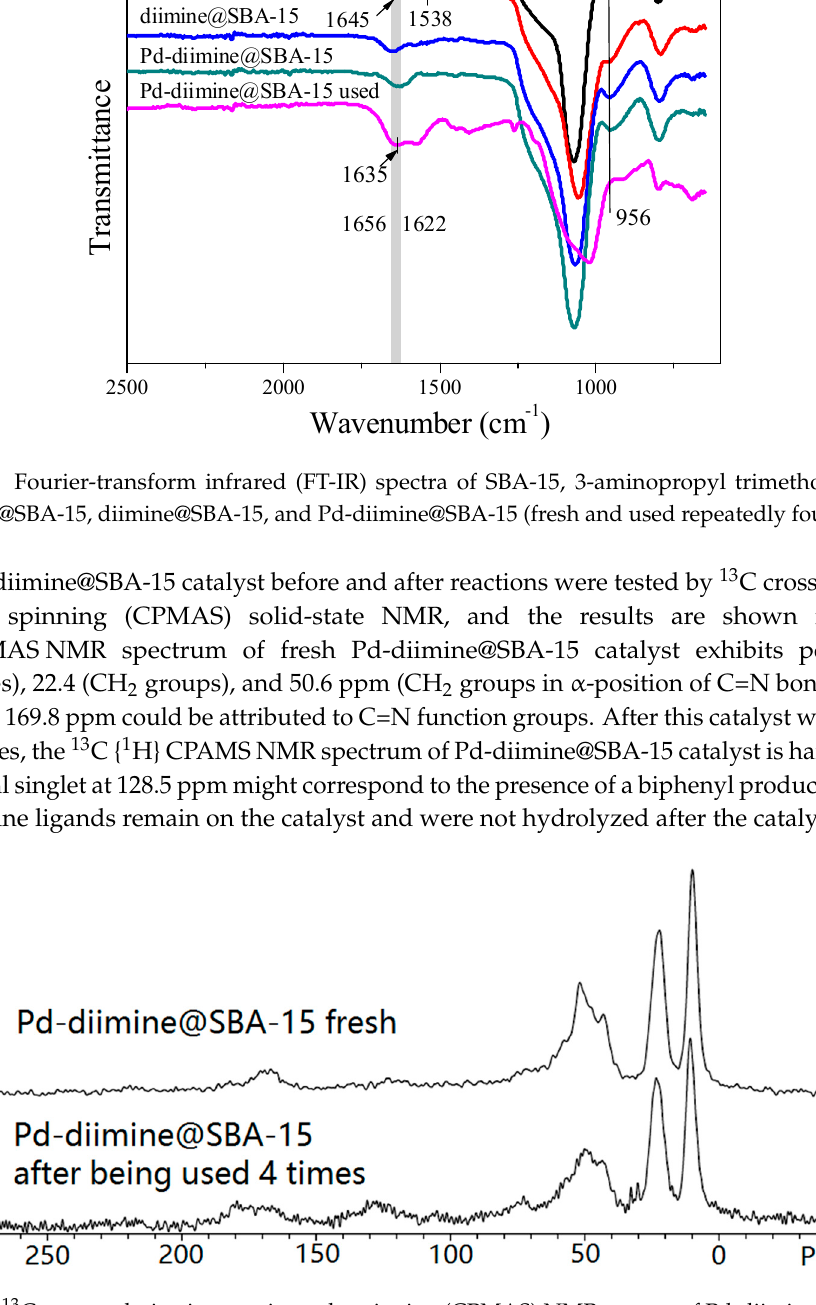
Figure 2. 13 C cross ‐ polarization magic ‐ angle spinning (CPMAS) NMR spectra of Pd ‐ diimine@SBA ‐ 15 before and after being repeatedly used four times.